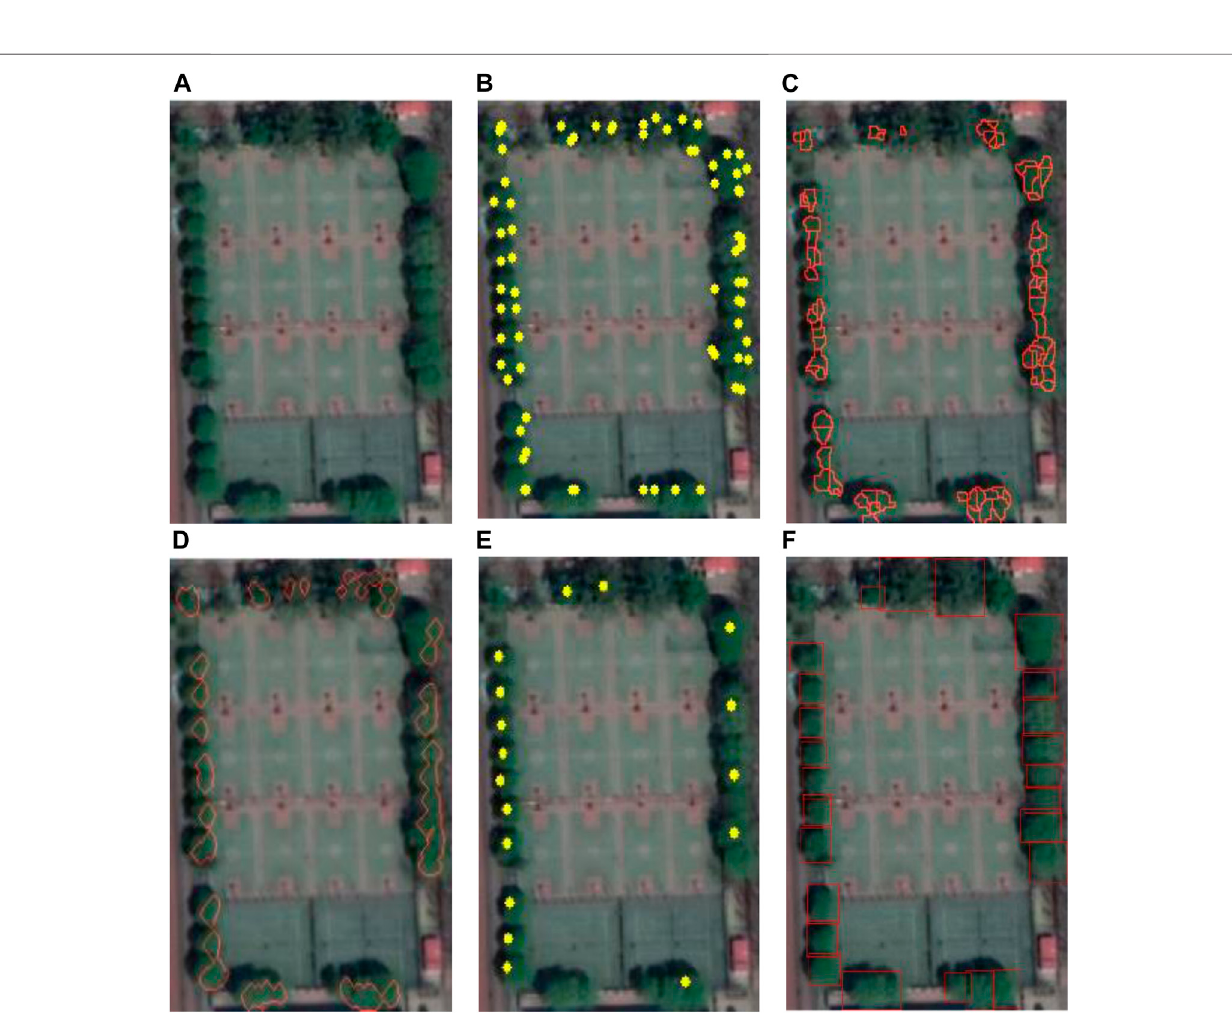
Frontiers in Environmental Science |